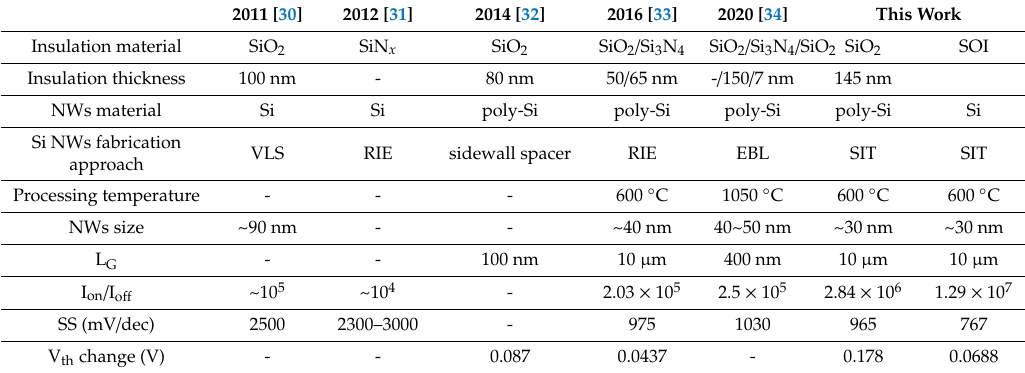
Table 1. A comparison of silicon nanowire sensors in recent